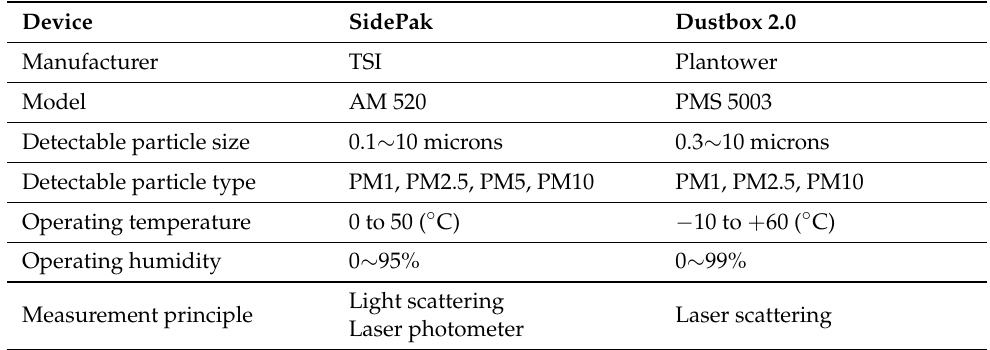
Table 1. Comparison between particulate matter sensors.